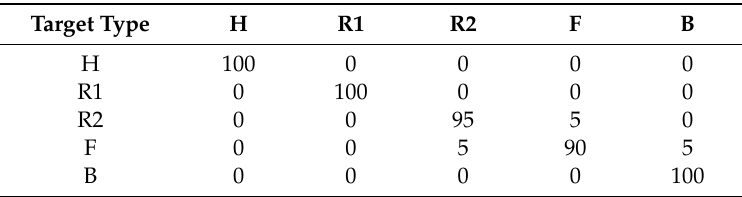
Table6. ConfusionmatrixoffivekindsofLSStargetsinamulti-dimensionalfeaturesfusionclassification system based on the KNN classifier